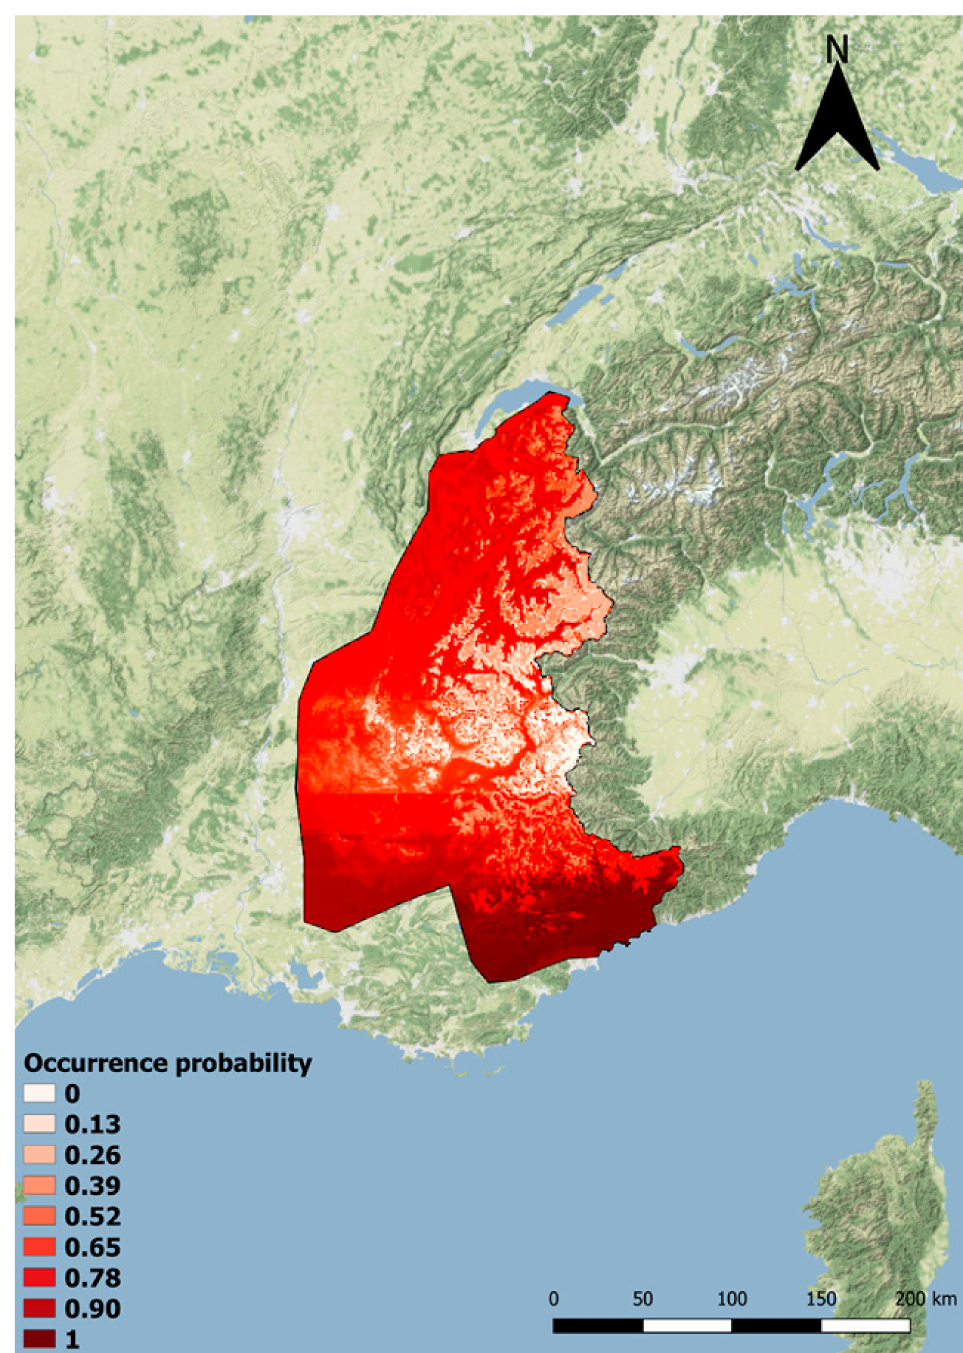
Figure 4. Species distribution model of C. hamulosa using a random forest model. The presence probability is represented on a scale from 0 to